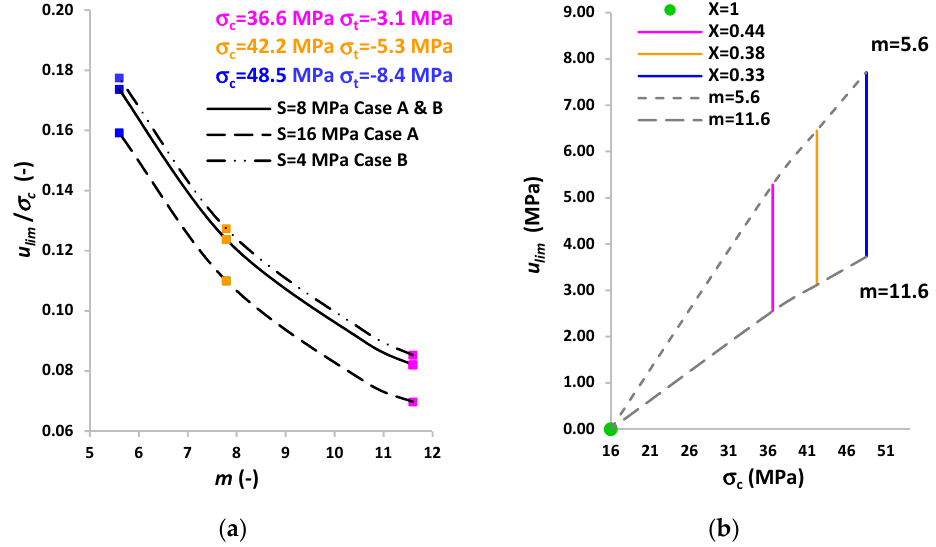
Figure 5. ( a ) Variation of u lim with S (Table 2) calculated at r = R with different couples of m and σ c found in the data fitting (Figure 2 and Table 1). Each u lim is normalized by the correspondent values of σ c ; ( b ) Variation of u lim with m = 5.6–11.6 at fixed σ c in Case A at ϑ = 0° ( S = 16 MPa).